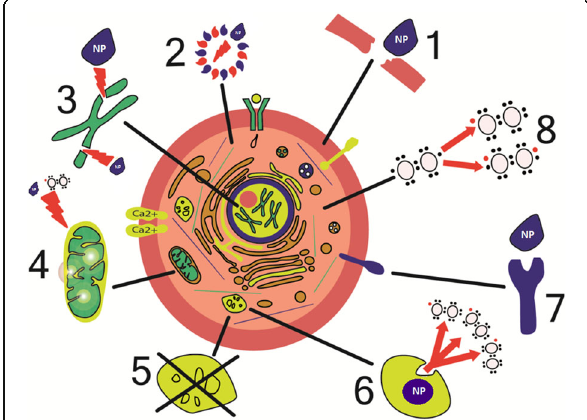
Fig. 1 Mechanisms of cell damage by nanoparticles. (1) Physical damage of membranes [43, 67, 75]. (2) Structural changes in cytoskeleton components [45, 46]. (3) Disturbance of transcription and oxidative damage of DNA [61, 62]. (4) Damage of mitochondria [39, 40]. (5) Disturbance of lysosome functioning [51]. (6) Generation of reactive oxygen species [61]. (7) Disturbance of membrane protein functions [172]. (8) Synthesis of inflammatory factors and mediators [54,